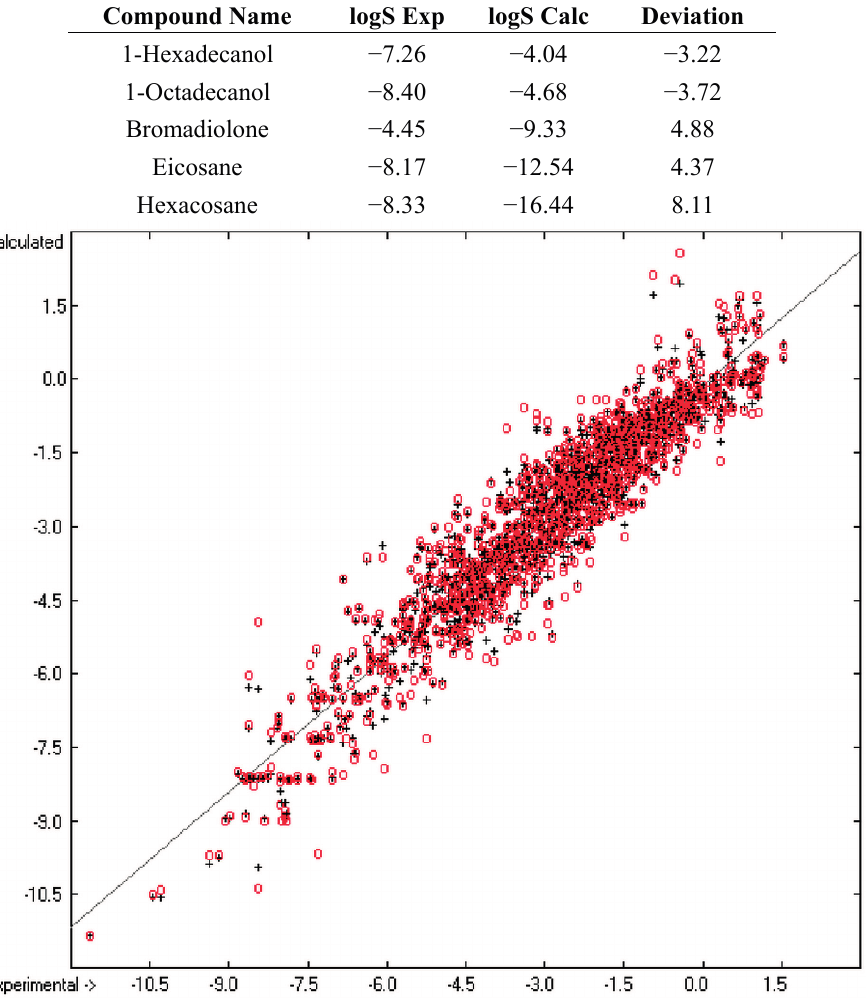
Figure 8. Correlation diagram of logS data (10-fold cross-validated: N = 1419, Q 2 = 0.8838, slope =